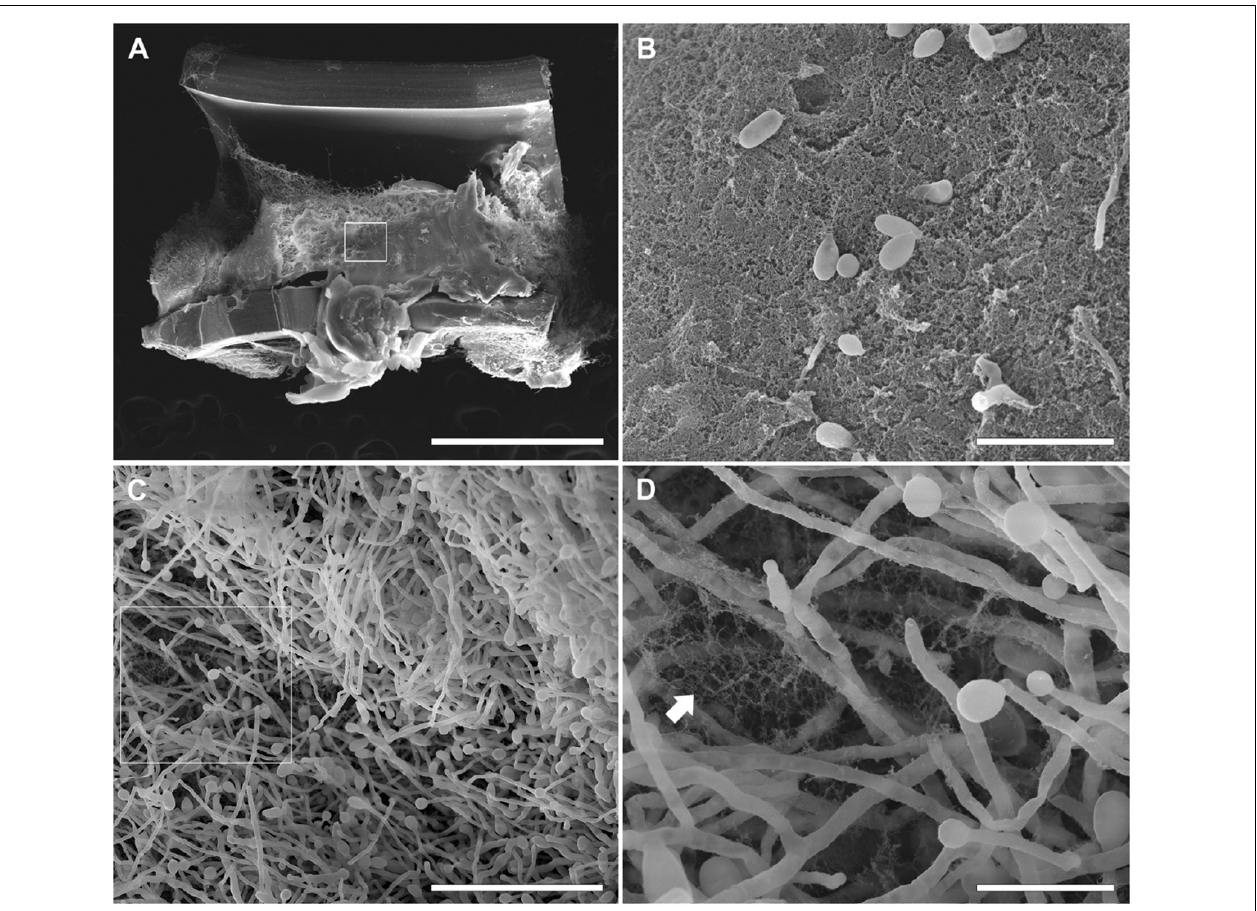
FIGURE 5 | Scanning electron microscopy of S. boydii clinical isolate (CBS 120157) biofilms grown on central venous catheters (CVCs). Biofilms were grown in vitro on the inner surface of 0.5 cm sections of sterile CVCs for 48 h. (A) A dense mass of S. boydii biofilm covered most of the CVC surface. (B) The inset of the white square shown in panel (A) shows an area of dense extracellular matrix (ECM; white arrow) and a dispersion of conidia. (C) A representative area of the internal biofilm. (D) An inset of the white square in panel. (C) showing a network of hyphae with ECM residues. Bars correspond to 1 mm (A) , 20 µ M (B) , 50 µ M (C) , and 10 µ M (D)